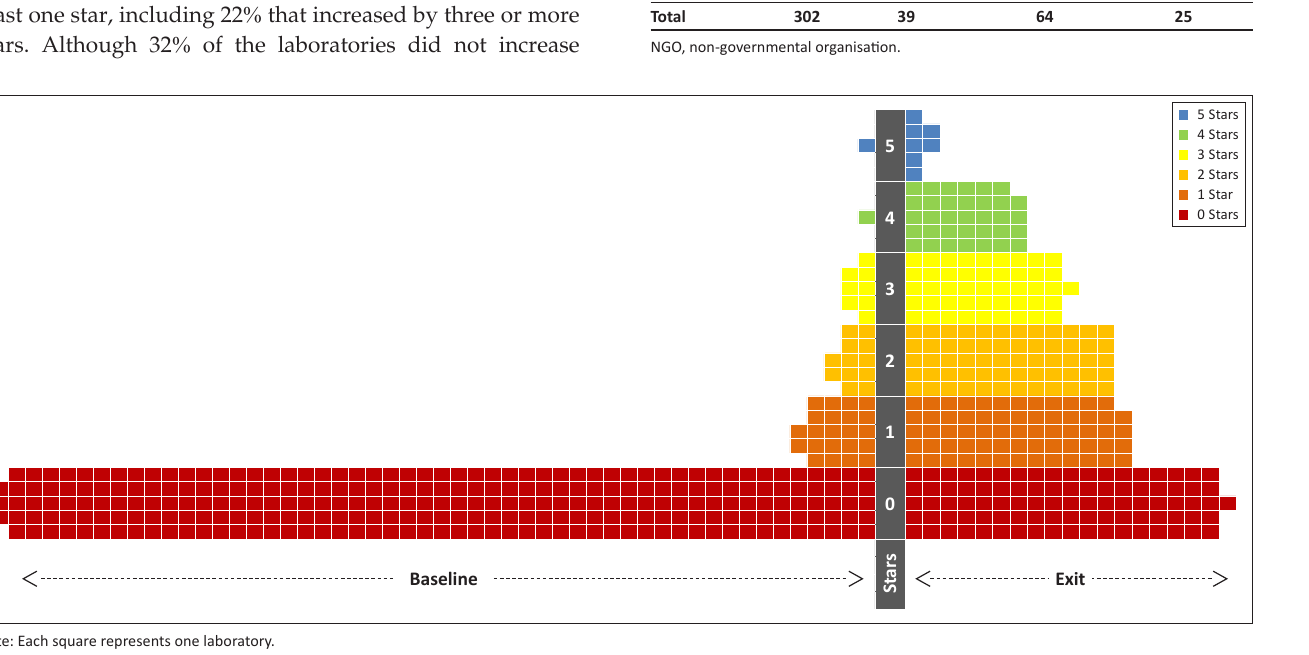
FIGURE 2: Star levels at baseline and exit amongst the 302 laboratories completing the Strengthening Laboratory Management Toward Accreditation programme, 2010–2013. Results based on the Stepwise Laboratory Quality Improvement Process Towards Accreditation checklist baseline and exit audit scores.